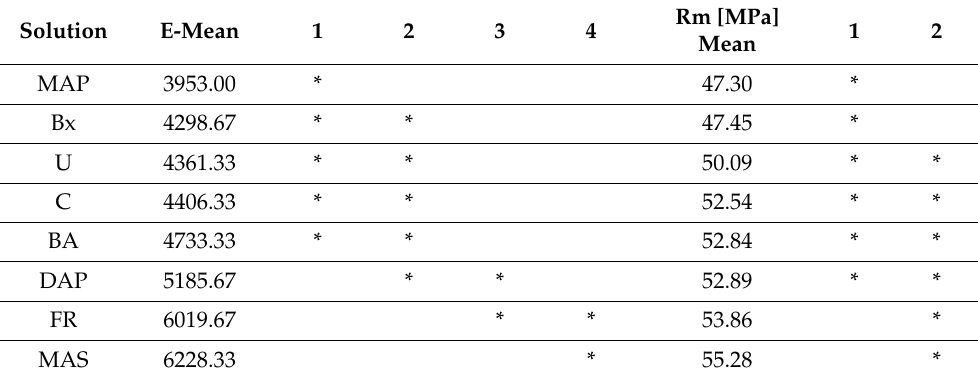
Table 1. Summary of statistically homogeneous groups determined on the basis of the HSD Tukey test for E and Rm. The symbol * meaning that results are not statistically